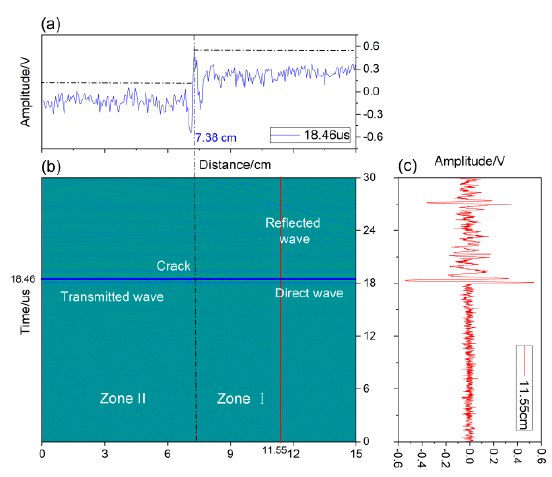
Figure 10. B-scan Figure 10. B-scan image.